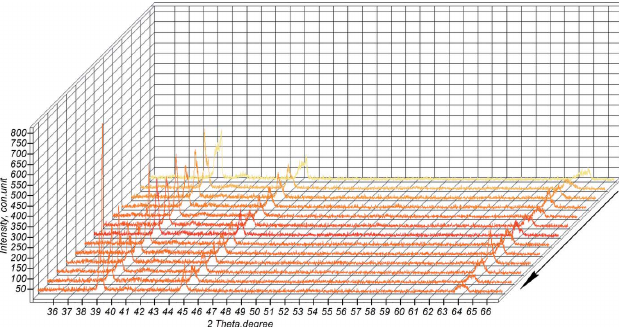
Figure 13 The thermal explosion section (the arrow indicates the direction of the reaction).